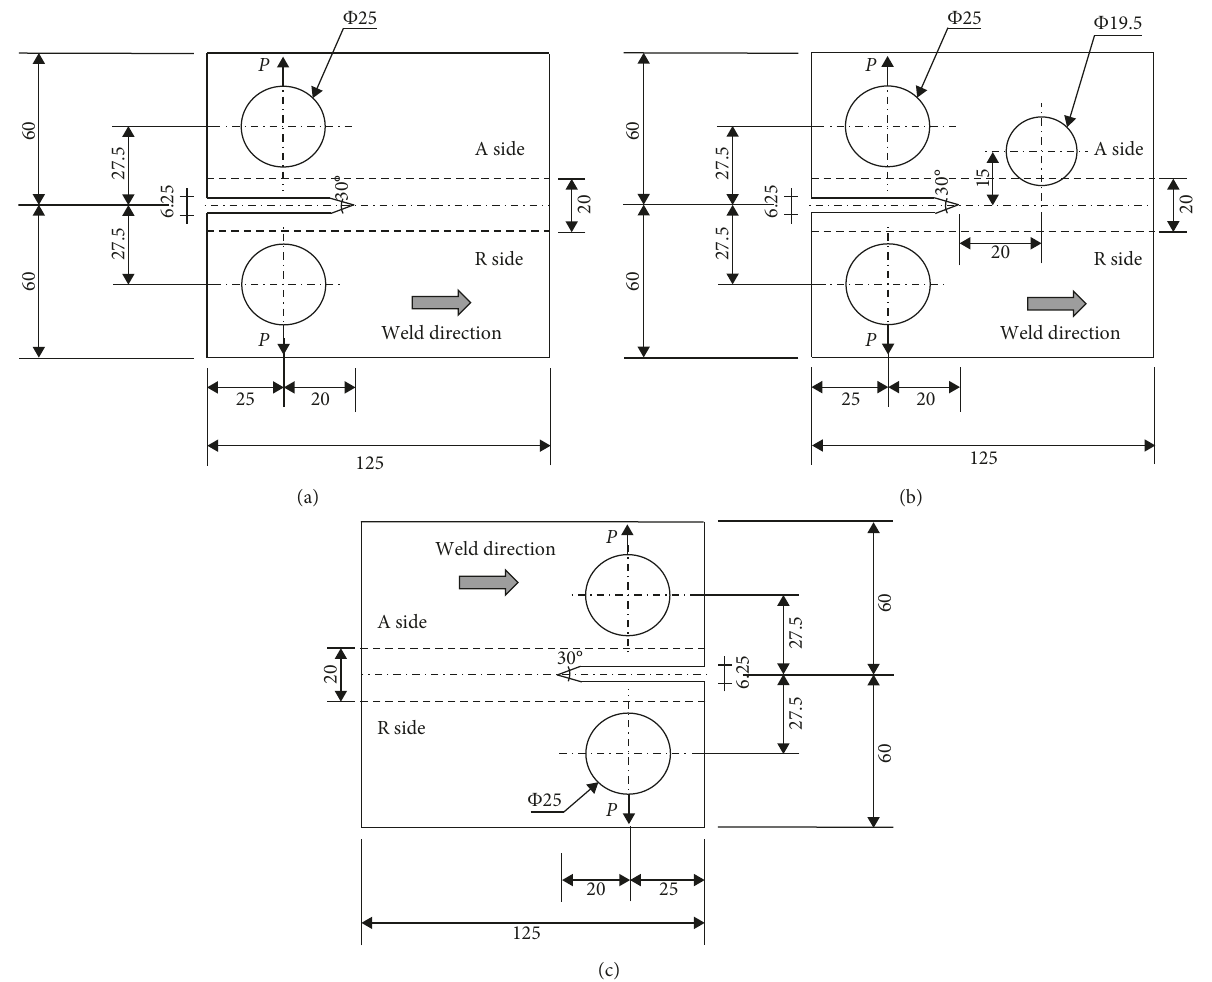
Figure 4: The configurations of FSWed samples. (a) CTspecimen (sample 1). (b) CTspecimen with a hole (sample 2). (c) CTspecimen for fatigue (sample 3). Table 1: Material properties of base metal.